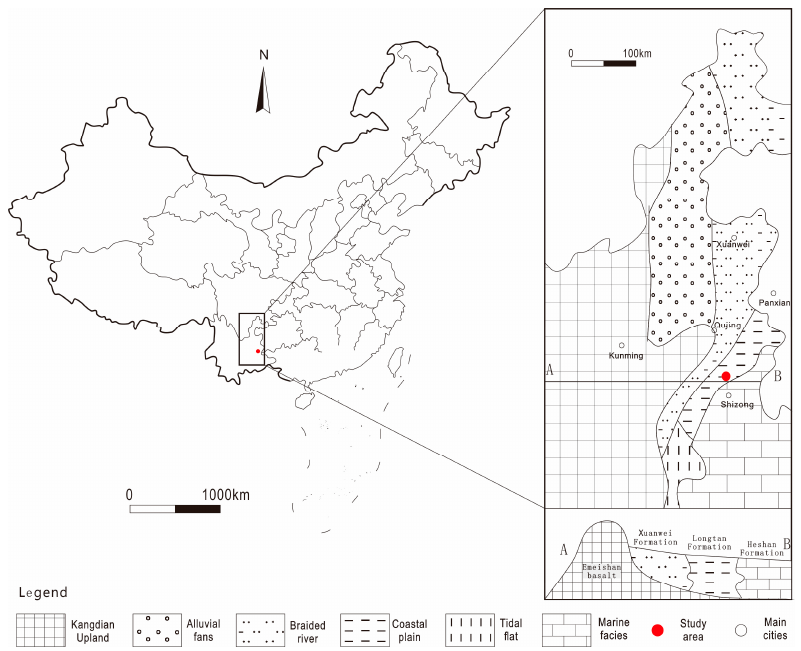
Figure 1. Location and sedimentary environments of the Lopingian Longtan Formation in the Shugentian Coalfield (modified from China Coal Geology Bureau, [23]).